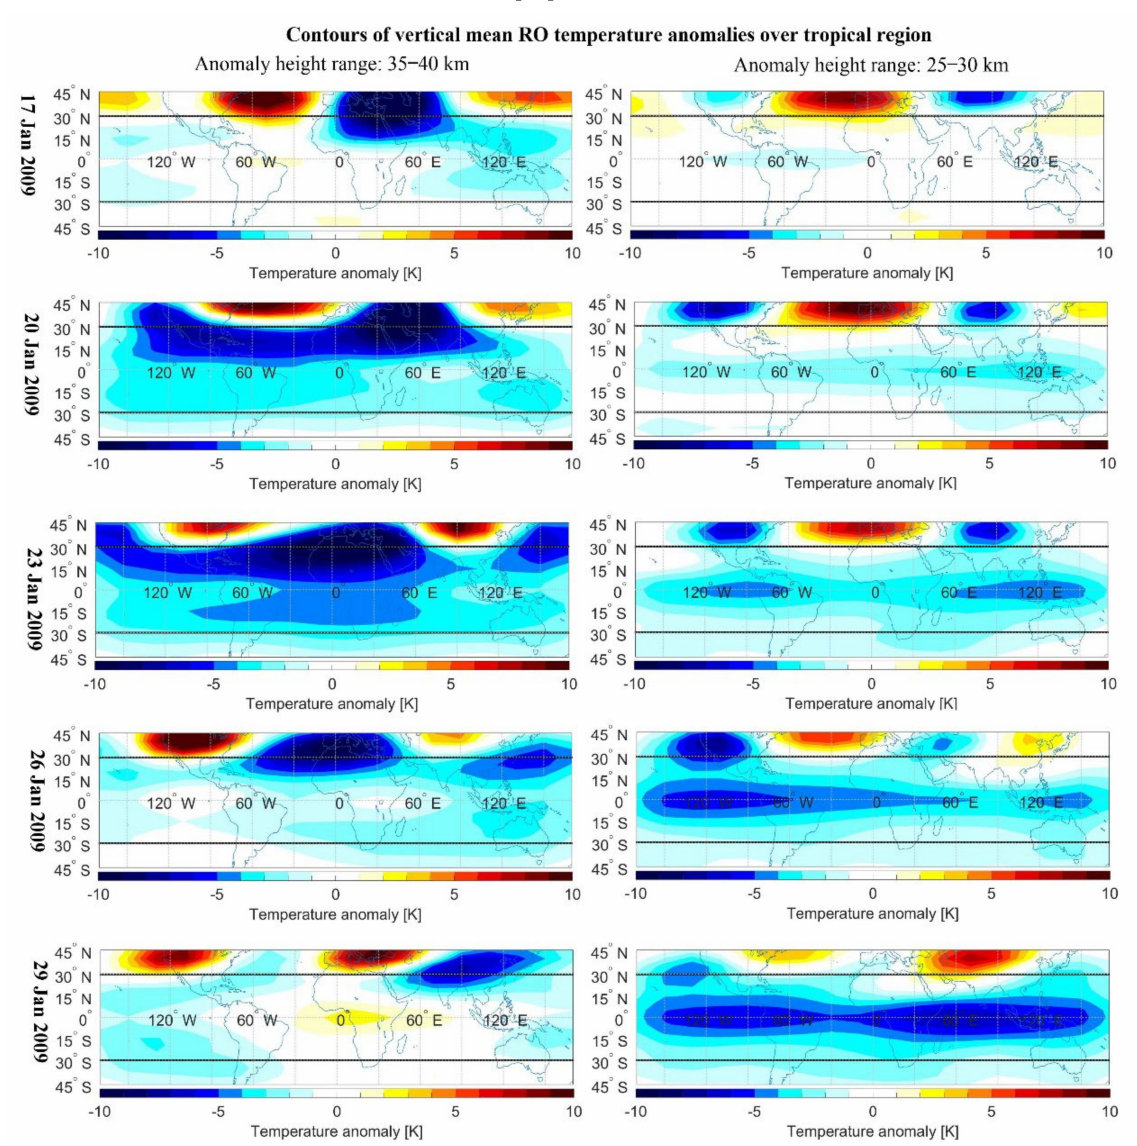
Figure 6. Latitude and longitude sectors of gridded mean RO temperature anomalies obtained from response altitude layer 35–40 km (left panels) and from downward altitude layer 25–30 km (right panels) on five exemplary days of 17, 20, 23, 26, and 29 January